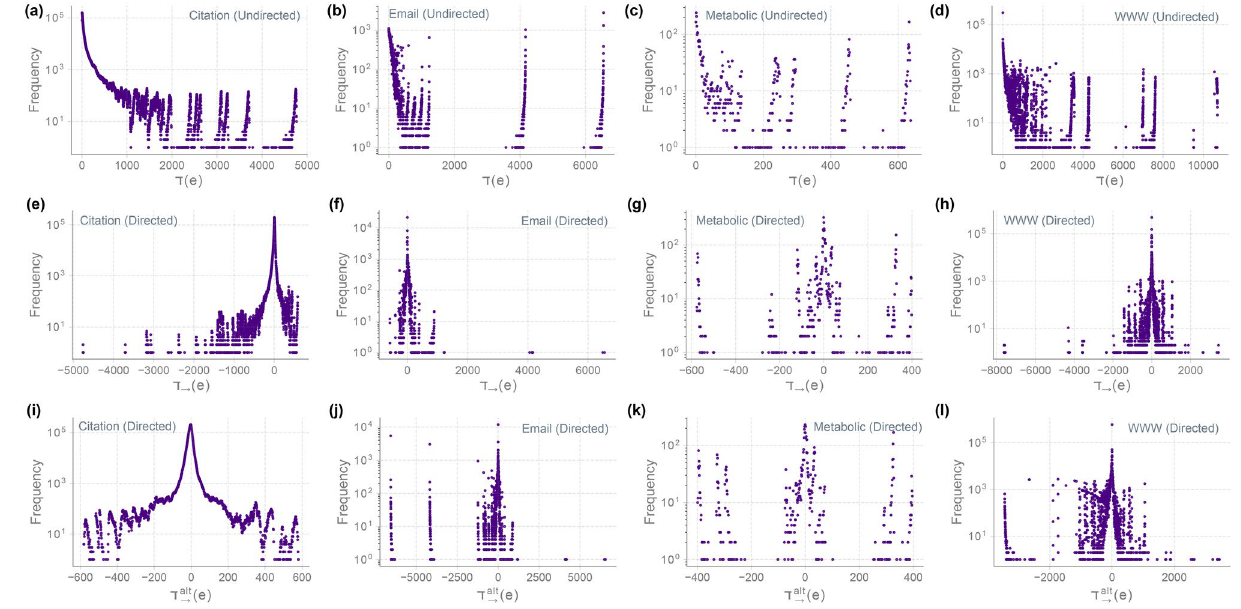
Figure 6. DD distributions in 4 directed real-world networks. ( a – d ) Distributions (cid:31) ( e ) computed using Eq. (5) by ignoring the directions of the edges. ( e – h ) Distributions (cid:31) → ( e ) computed using the directed definition